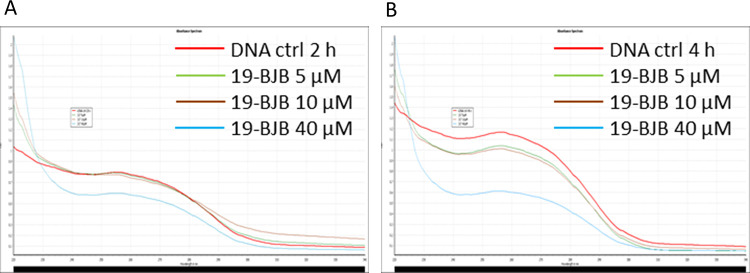
UV-visible (220 nm—350 nm) absorption spectra of the 19-BJB conjugated with DNA at different concentrations.(A) DNA fragment was treated with 19-BJB at different concentration (0, 5, 10, 40 μM) for 2 h. (B) DNA fragment was treated with 19-BJB at different concentration (0, 5, 10, 40 μM) for 4 h.